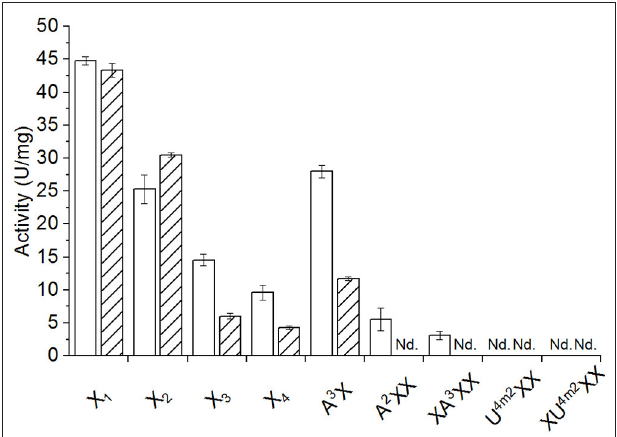
FIGURE 1 | Activity of AbPDH1 (white) and AmPDH1 (with diagonal stripes) on 10mM of neutral or 2mM of acidic xylooligosaccharides at pH 7.5 using Fc + ion as electron acceptor. X 1 , xylose; X 2 , xylobiose; X 3 , xylotriose; X 4 , xylotetraose; A 3 X, 3 2 - α -L-arabinofuranosyl-xylobiose; A 2 XX, 2 3 - α -L-arabinofuranosyl-xylotriose; XA 2 XX, 3 3 - α -L-arabinofuranosyl-xylotetraose; U 4m2 XX, 2 3 -(4- O -methyl- α -D-glucuronyl)-xylotriose; XU 4m2 XX, 2 3 -(4- O -methyl- α -D-glucuronyl)-xylotetraose. Error bars represent standard deviation of three replicate reactions. Reactions with U 4m2 XX and XU 4m2 XX were done in duplicates. Nd., no activity detected under these conditions after